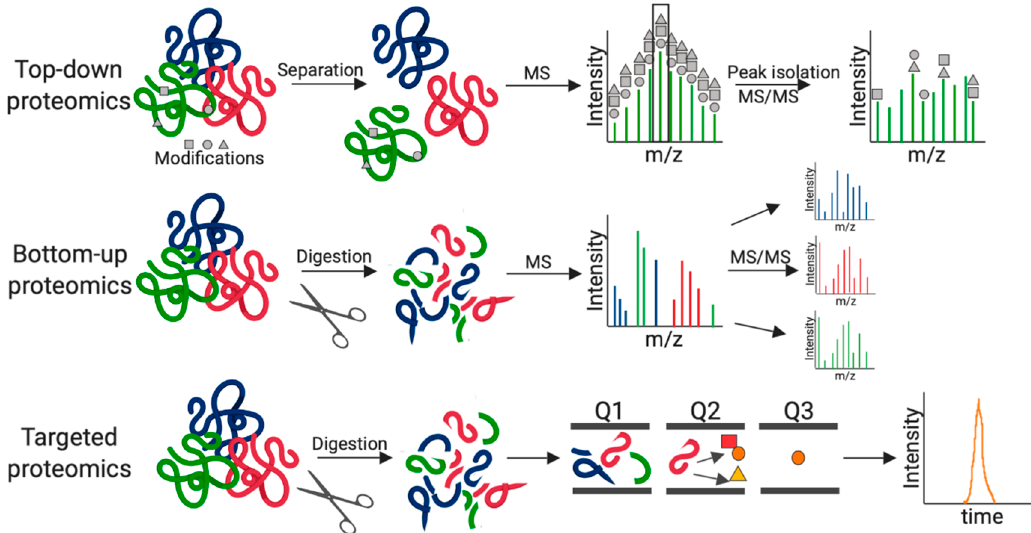
Figure 2. Graphical representation of MS-based proteomics workflows. Top-down proteomics analyzes intact proteins by LC–MS / MS for the identification and quantification of unique proteoforms following separation of proteins by size and peak isolation. Bottom-up proteomics measures proteolytic digested proteins (peptides) by LC–MS / MS for unbiased identification and quantification of proteins within a sample. Targeted proteomics measures a pre-defined set of peptides (isolation of parent ion by mass in Q1, collision of the ion Q2, and mass filtering of product ion in Q3) by LC–MS / MS for identification, characterization, and quantification of specific proteins and biomarkers. Figure generated using BioRender.com.